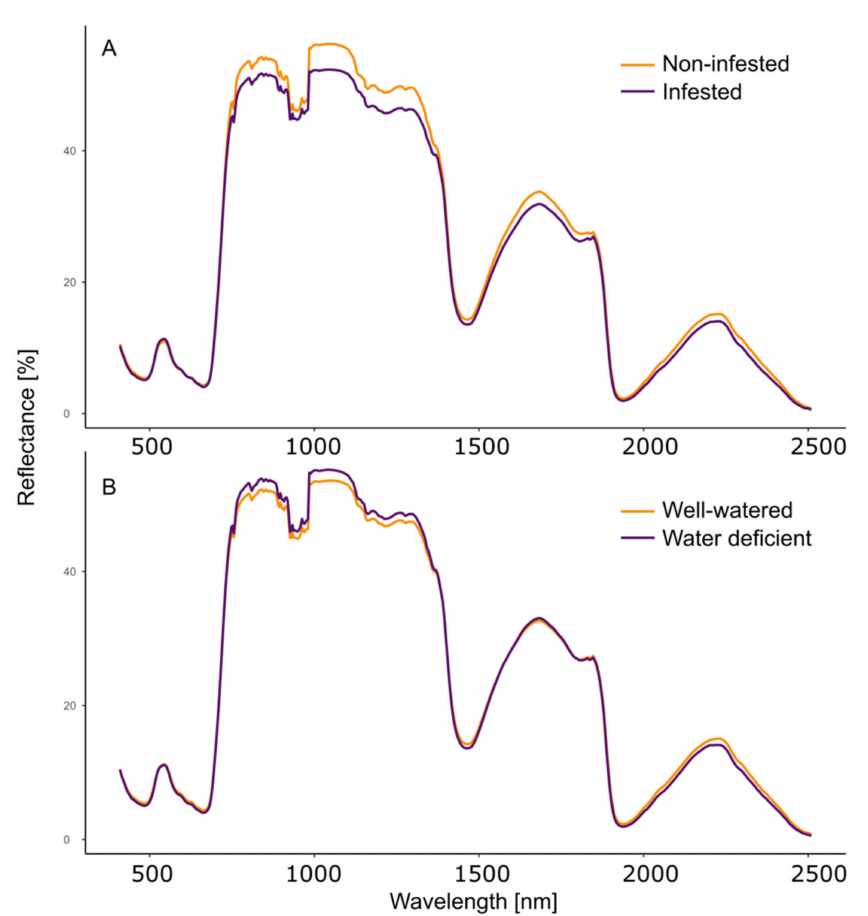
Figure 5. Mean spectra of plants from two analysis groups. ( A ) Non-infested and wireworm-infested plants; ( B ) well-watered and water-deficient plants. Note the very similar spectral signatures in the visible part of the spectrum (400–750 nm) and increased differences in the NIR (750–1000 nm) and SWIR (900–2500 nm)